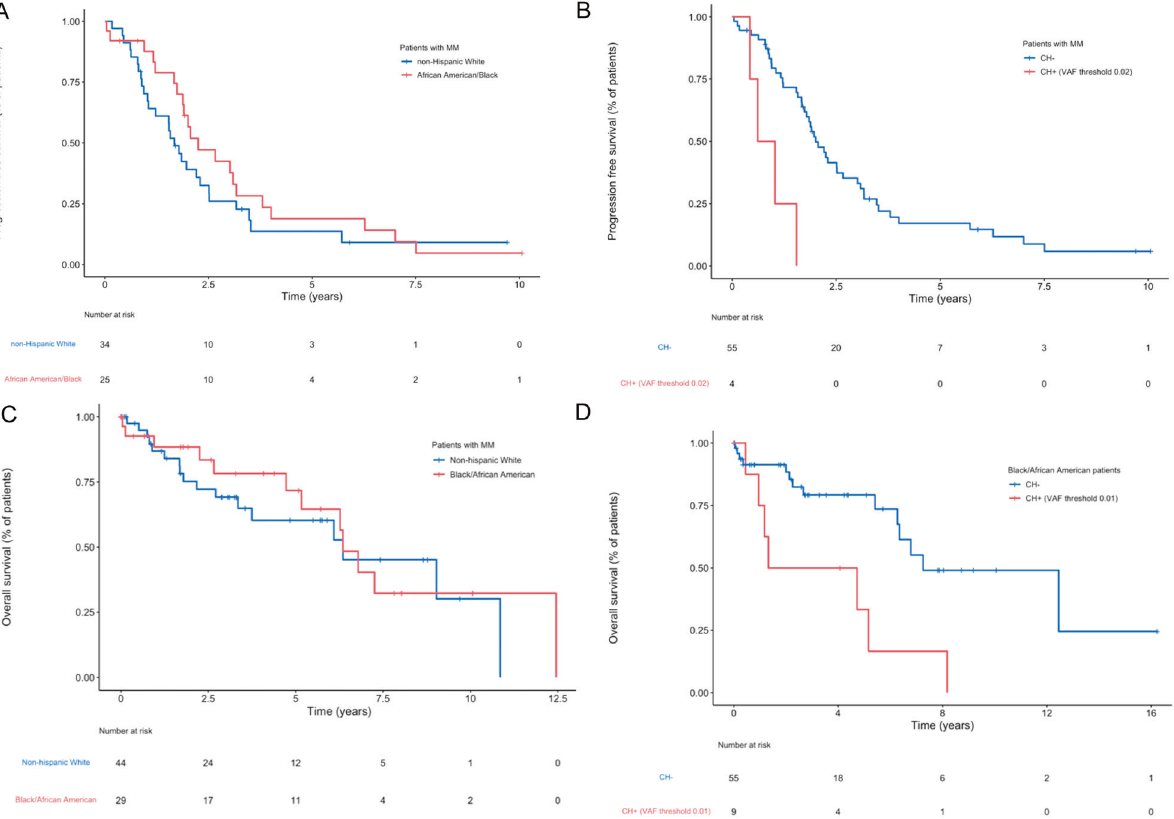
Fig. 1 Progression-free survival and overall survival according to race, ethicity, PCN type and CH status. A Progression-free survival for patients with multiple myeloma according to race and ethnicity (HR = 0.72, 95% CI: 0.41 – 1.28; p = 0.26). B Progression-free survival for patients with multiple myeloma according to clonal hematopoiesis status (VAF ≥ 0.02) (HR = 5.52, 95% CI: 1.82 – 16.74; p = 0.003). C Overall survival of patients with multiple myeloma based on race and ethnicity. D Overall survival of Black/African American patients with PCN according to CH status (VAF ≥ 0.01) (HR = 4.57, 95% CI: 1.48 – 14.1; p = 0.008). CH clonal hematopoiesis, MM multiple myeloma, PCN plasma cell